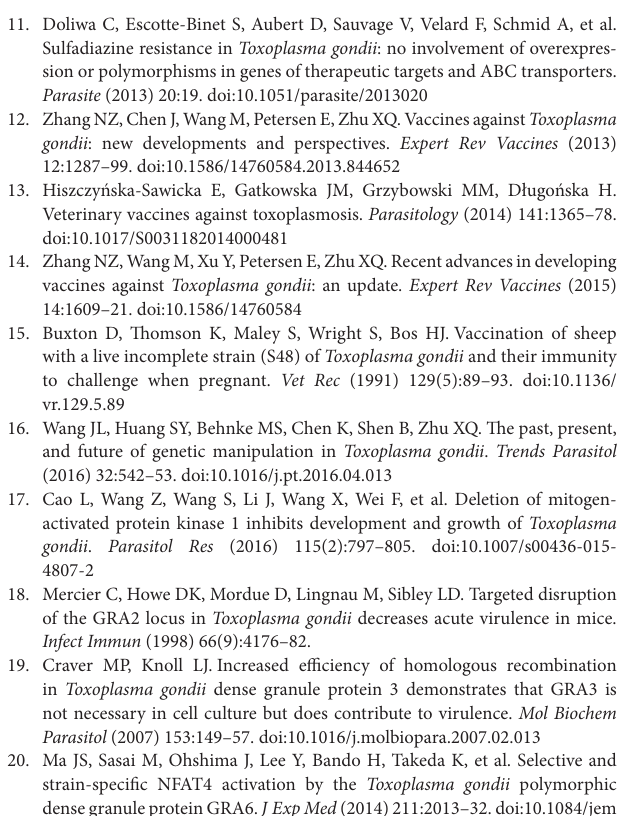
TaBle s1 | Details of single guide RNA and identification primers used in this study. FigUre s1 | Schematic illustration of the study design. Experimental overview of the present investigation from immunization of Kunming mice with 5 × 10 4 Δ GRA17 tachyzoites (a) , assessment of immune responses in the serum of immunized mice prior to infection (B) to the evaluation of the efiicacy of the immunization against acute infection (c) , chronic infection (D) , and congenital infection (e) . For simplicity in this illustration, only the experiments that involved the immunized and infected groups are shown. More details about other experimental mouse groups and controls can be found in “Materials